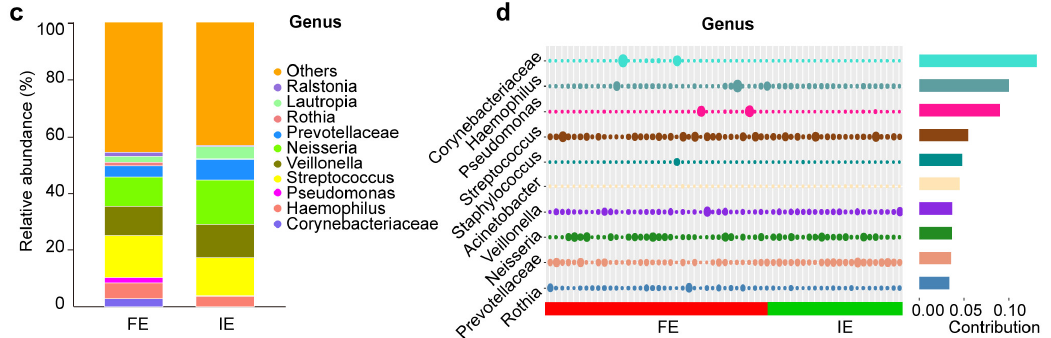
Figure 2. Bacterial community structure in FE (n = 37) and IE (n = 22) group. Relative abundance and Simper analysis of the most prevalent bacteria and at the phylum ( a , b ) and genus levels ( c , d ) in FE and IE group. The bubble size represents the relative abundance of the species, and the contribution represents the contribution of the species in the two groups of differences. FE frequent exacerbator, IE infrequent exacerbator.